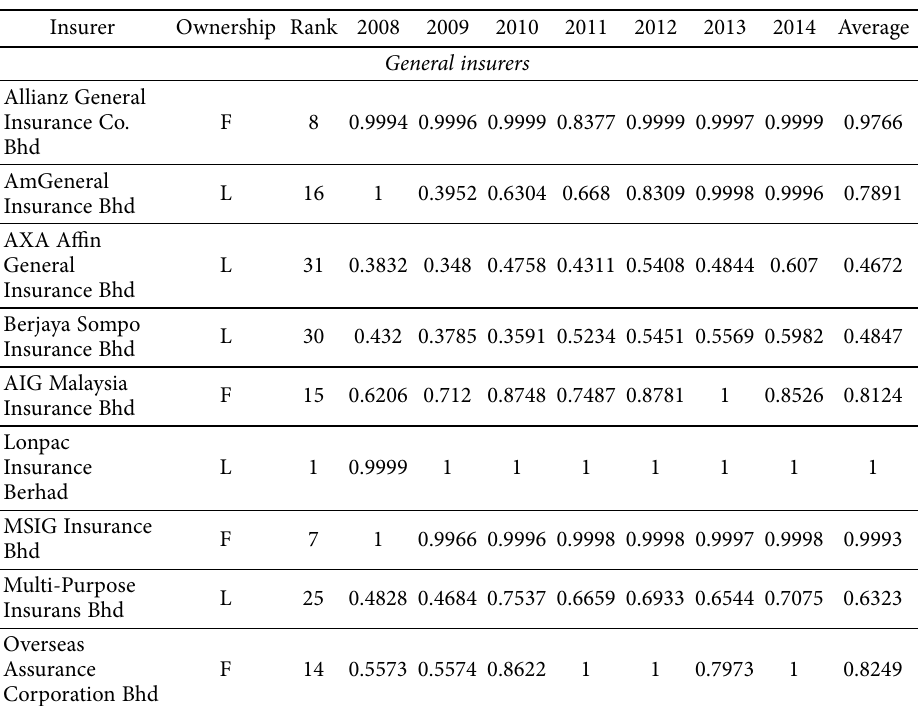
Table 6. Investment capability efficiency scores for Malaysian